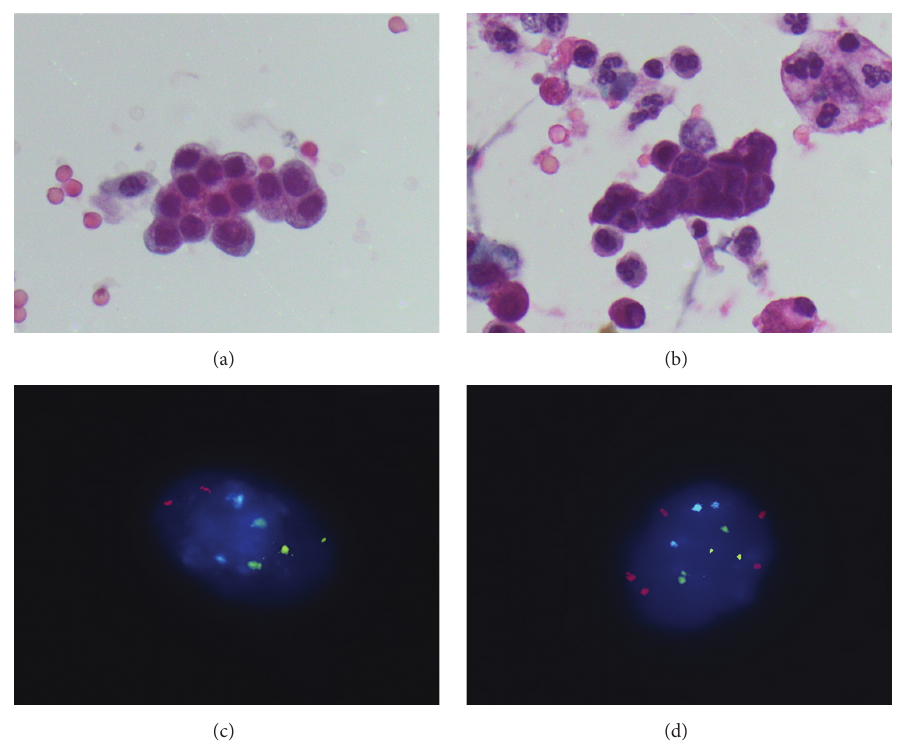
Figure 1: Representative examples of conventional cytology and DNA FISH of biliary brushing specimens. ((a) and (b)) Conventional cytology. (a) Reactive changes in the context of PSC with some architectural irregularity, mild variation in nuclear size, and overall intact nuclear to cytoplasmic ratio. (b) Adenocarcinoma in a patient with underlying PSC showing hyperchromatic nuclei, marked variation in nuclear shape and size with nuclear molding, and severely disturbed nuclear to cytoplasmic ratio. In the background, necrotic debris with degenerative cells and granulocytes are observed. ((c) and (d)) Representative examples of FISH signal patterns seen in biliary strictures with probes for CEP7 [aqua], CEP17 [green], 20q [gold], and MYC [red]. (c) A normal cell (2 signals of each probe) and (d) gain of MYC ( > 2 red signals) and gain of CEP7 ( > 2 blue